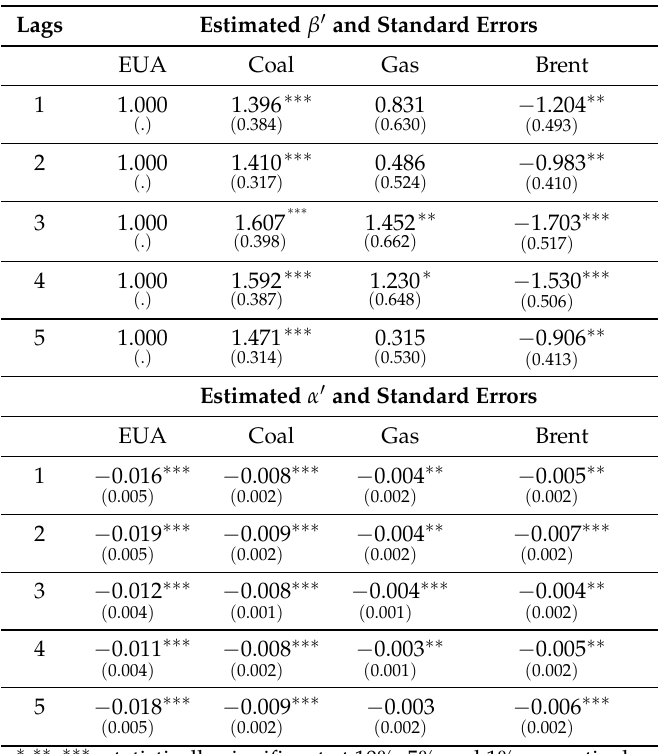
Table 2. Estimated coefficients in Equation (1) for the long- and short-run relationship ( β and α , respectively) of the daily forward price